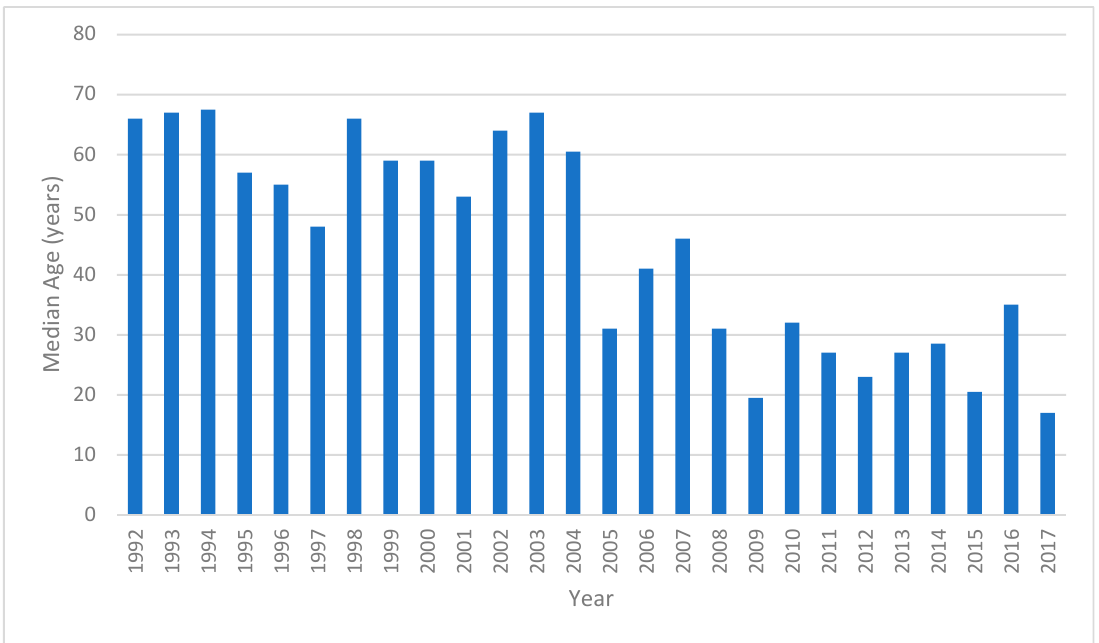
Figure 2. Median age of notified TB cases between 1992 and 2017.